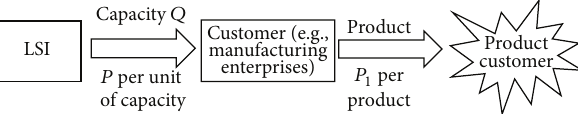
Figure 1: Logistics service supply chain (LSSC)